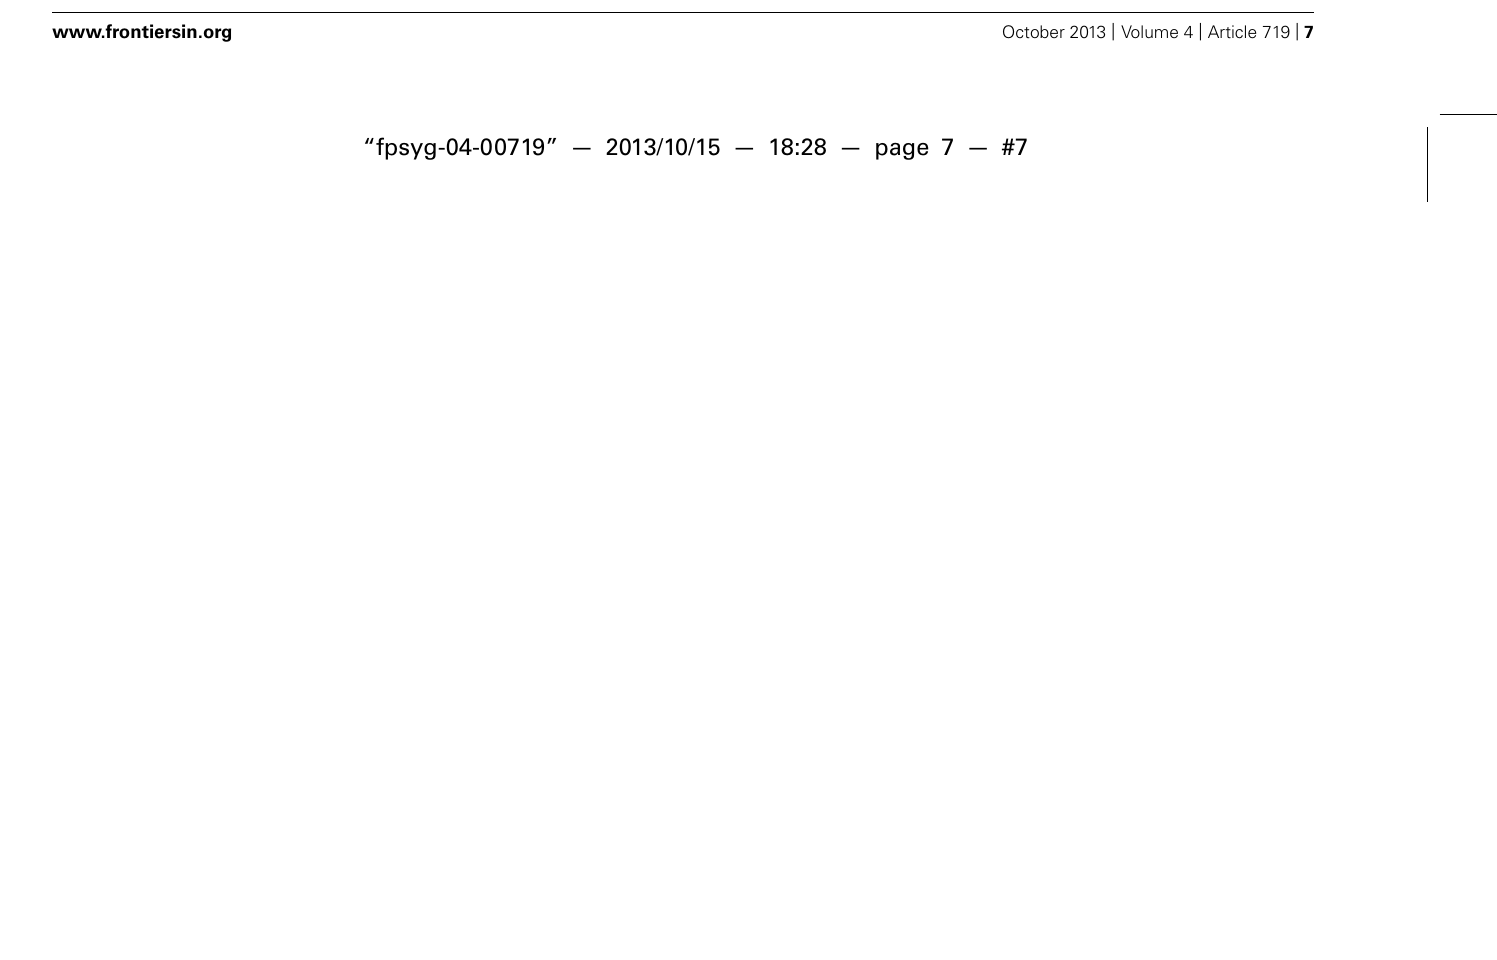
and right hemispheric sources of P1 (normal hearing) and P1ci (cochlear implant users for stimulation from right/CI-1 and left/CI-2). Large peaks in responses to CI-1 (right) stimulation can be seen in the long delay and unilateral group data. (C) Left and right hemispheric dipole moments (mean ± 1 SE) for P1/P1ci in each group in response to right/CI-1 and left/CI-2 stimulation. In response to CI-1 (right) stimulation, there is a marked increase in left hemispheric dipole moments in participant groups with > 2 years of unilateral hearing experience (long delay and unilateral; p < 0.05).” (Gordon etal., 2013; Brain, Figure 7, p.